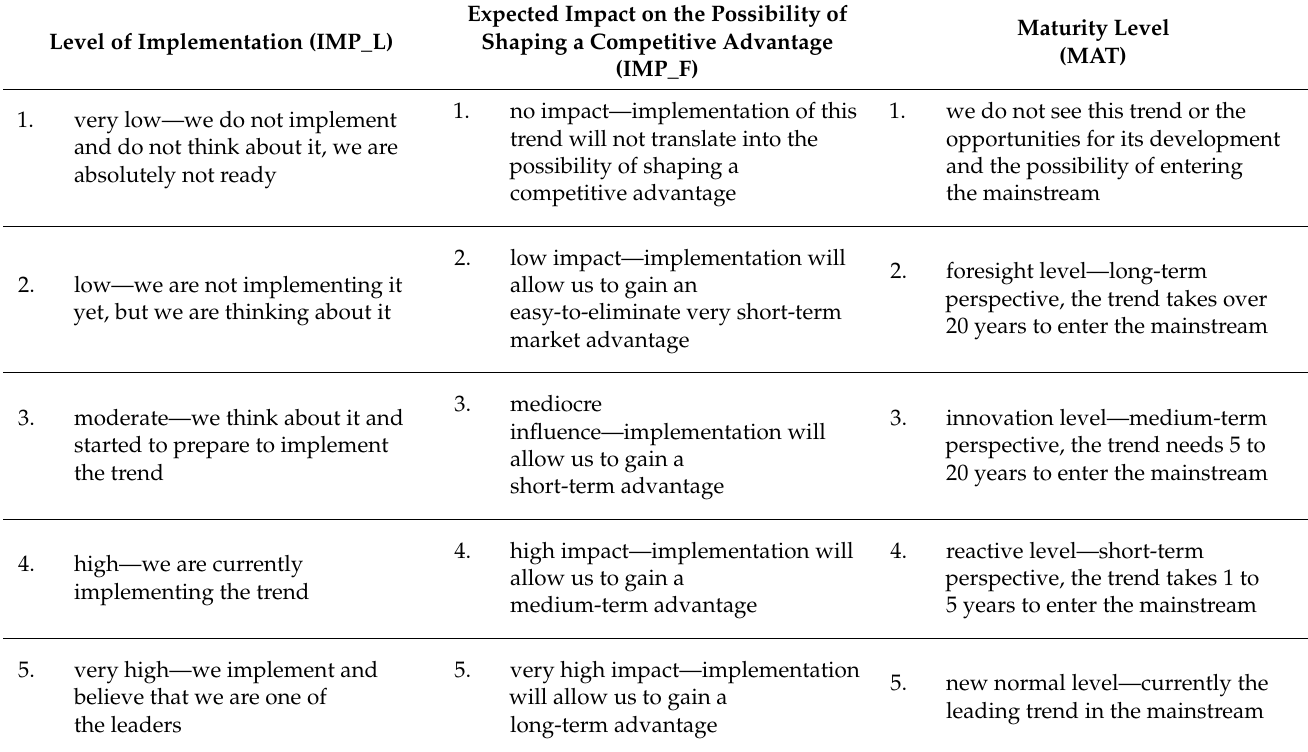
Table 2. Grading scale for S.T.F.E.C. SMART management trends.